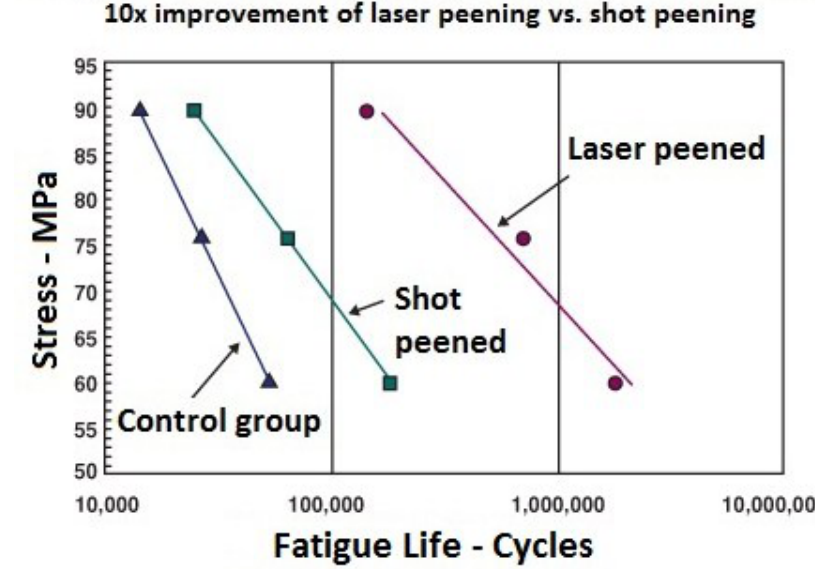
Figure 19. Fatigue life of 6061-T6 aluminum after LSP and SP